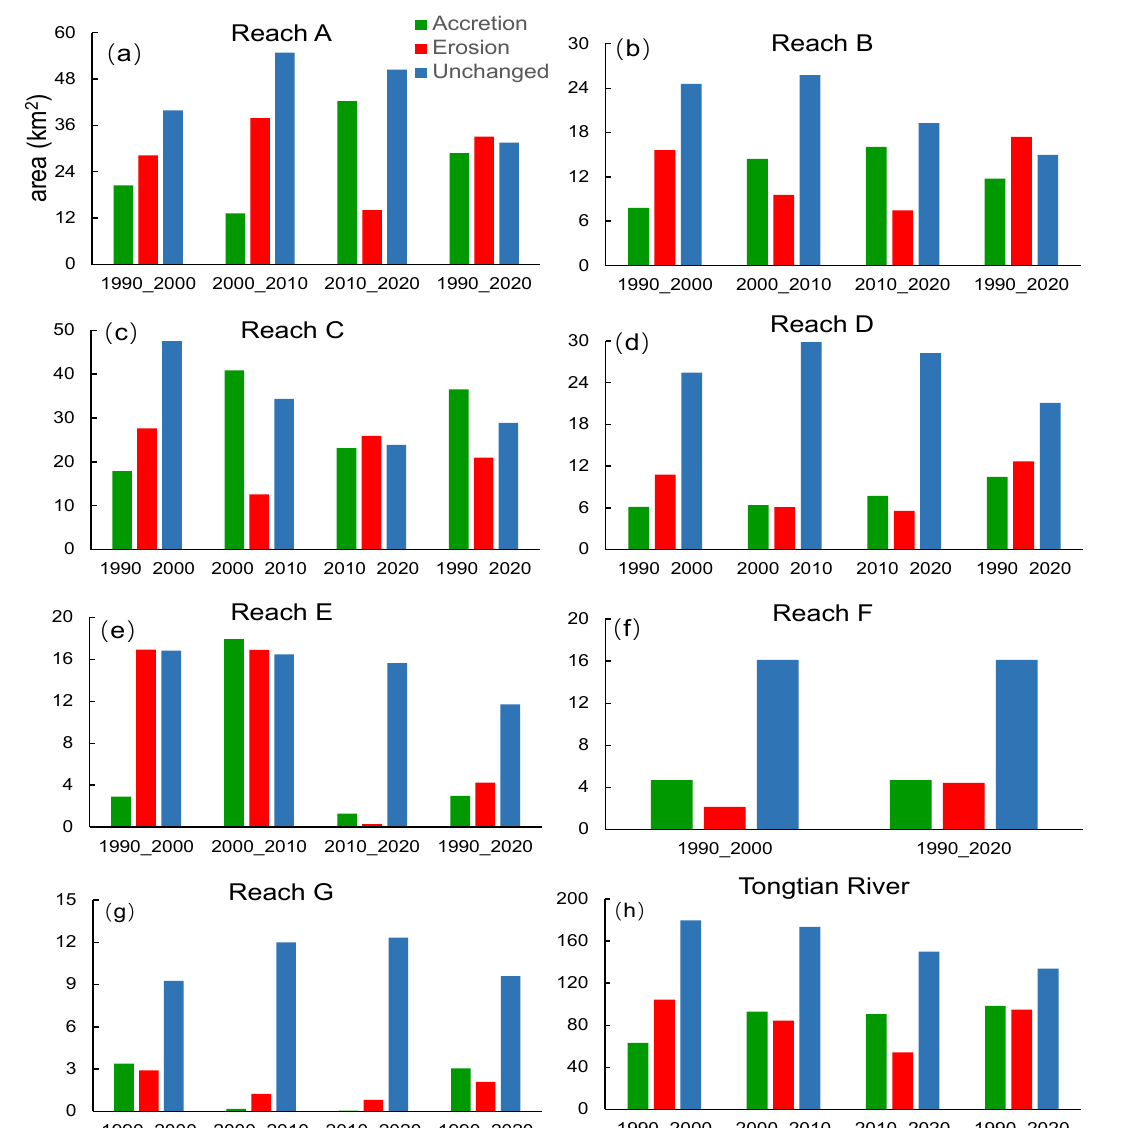
Figure 9. Channel lateral erosion, accretion, and unchanged area at various reaches along the Tongtian River during the four study periods since 1990. Note that the ranges of the vertical axis are different.